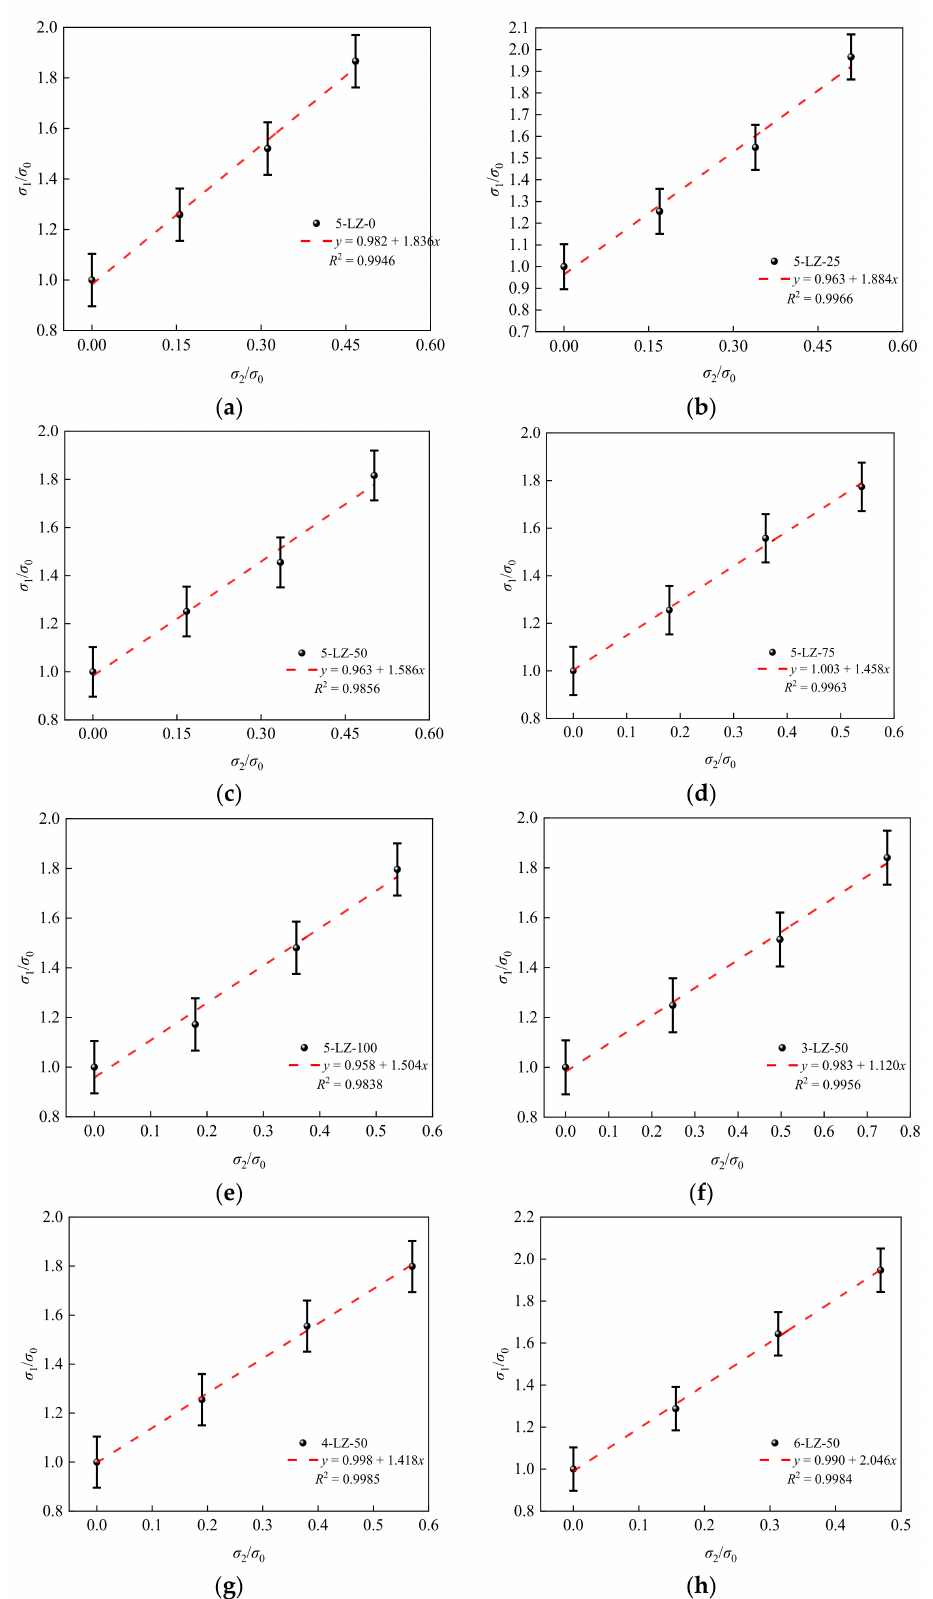
Figure 12. Relationship between the peak stress and confining pressure: ( a ) 5-LZ-0, ( b )